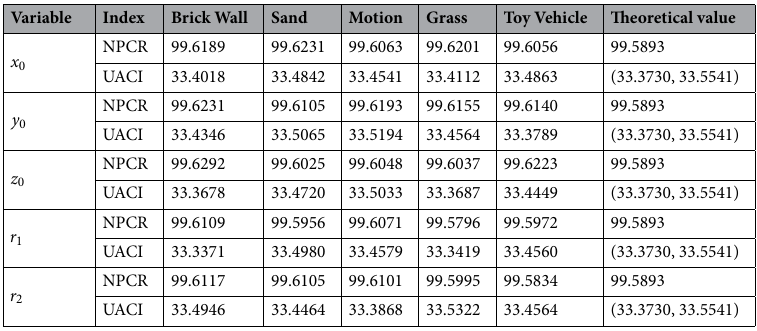
Table 8. Key sensitivity analysis.